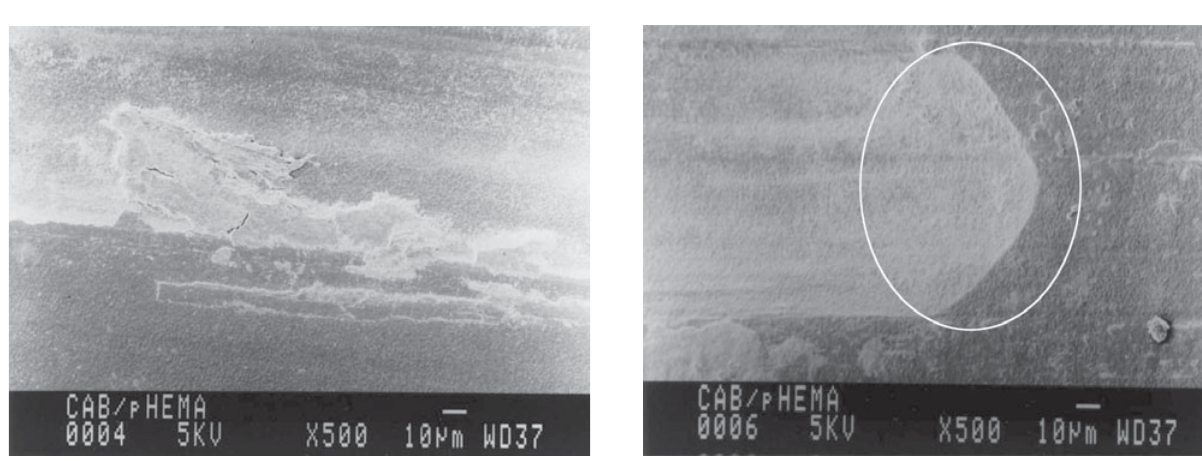
Figure 2. SEM worn surface of the pHEMA-CAB blend. Figure 4. SEM worn surface of the pHEMA-CAB